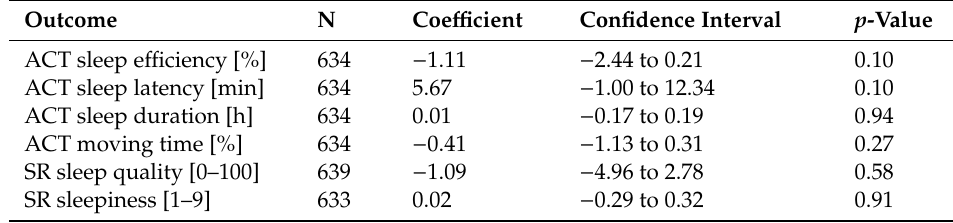
Table 3. Adjusted association between sleep outcomes and measured outdoor nighttime noise (L eq,night ) per 10 dB(A)